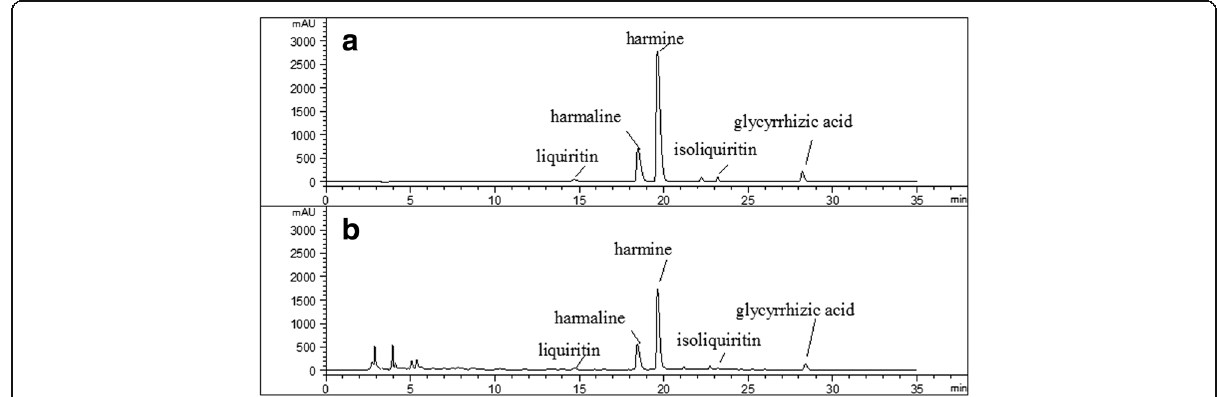
Fig. 1 The typical HPLC fingerprint chromatograms of reference standards of liquiritin, harmaline, harmine, isoliquiritin and glycyrrhizic acid ( a ) and MNZQ sample ( b